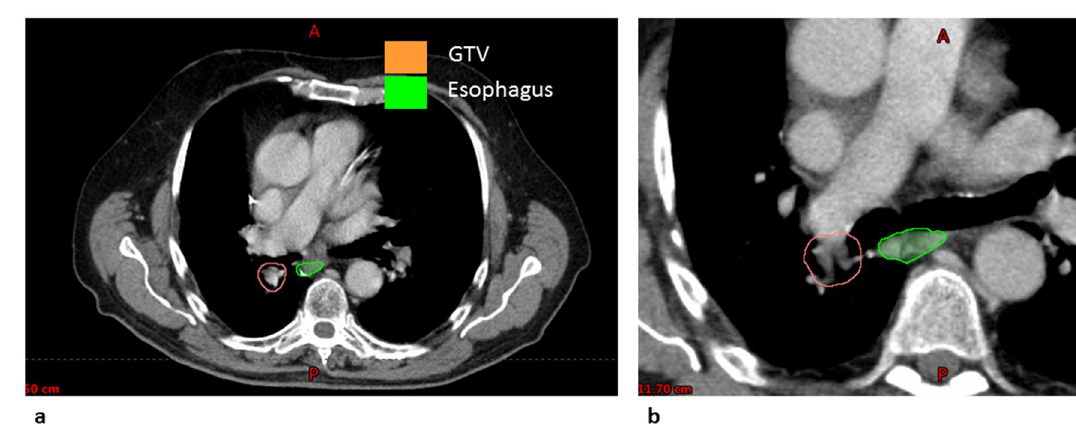
Figure 8. CT in transversal view ( a ) of patient case 7 showing the proximity of the GTV to the esophagus. Figure ( b ) shows a zoomed transversal view for the same patient but a different CT